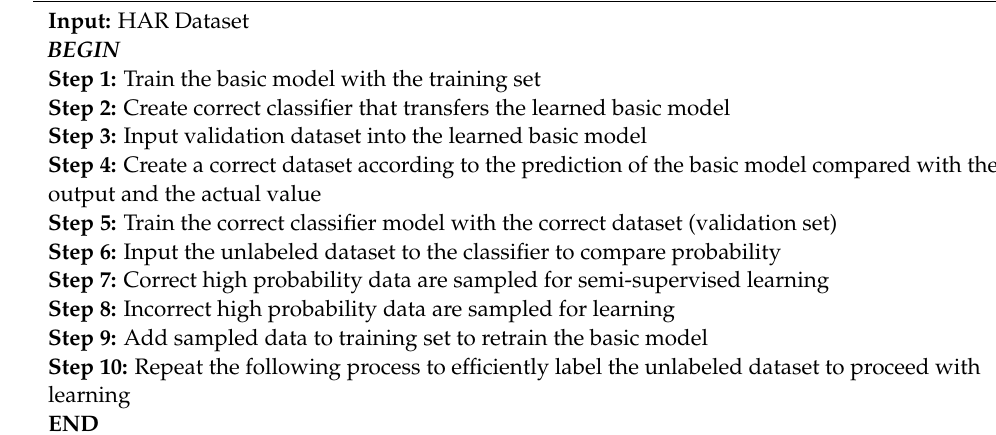
Figure 4. ( a ) DNN based basic model. ( b ) Transferred correct classifier model. Algorithm 1. Semi-Supervised Active Transfer Learning Algorithm